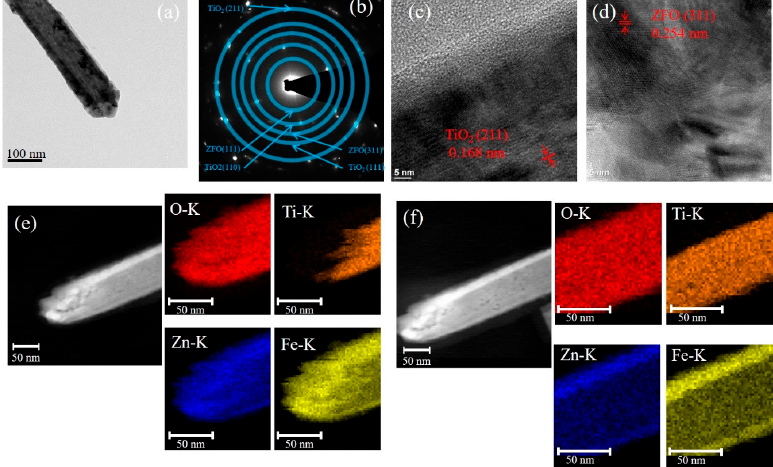
Figure 2. TEM analyses of TiO 2 –ZFO-1 nanorods: ( a ) low-magnification micrograph of the single nanorod; ( b ) selected area electron diffraction (SAED) pattern; ( c – d ) high-resolution TEM (HRTEM) micrographs in the lateral and head regions of the nanorod, respectively; ( e ) Zn, Fe, Ti, and O mapping micrographs in the head region of the nanorod; ( f ) Zn, Fe, Ti, and O mapping micrographs in the lateral region of the nanorod .